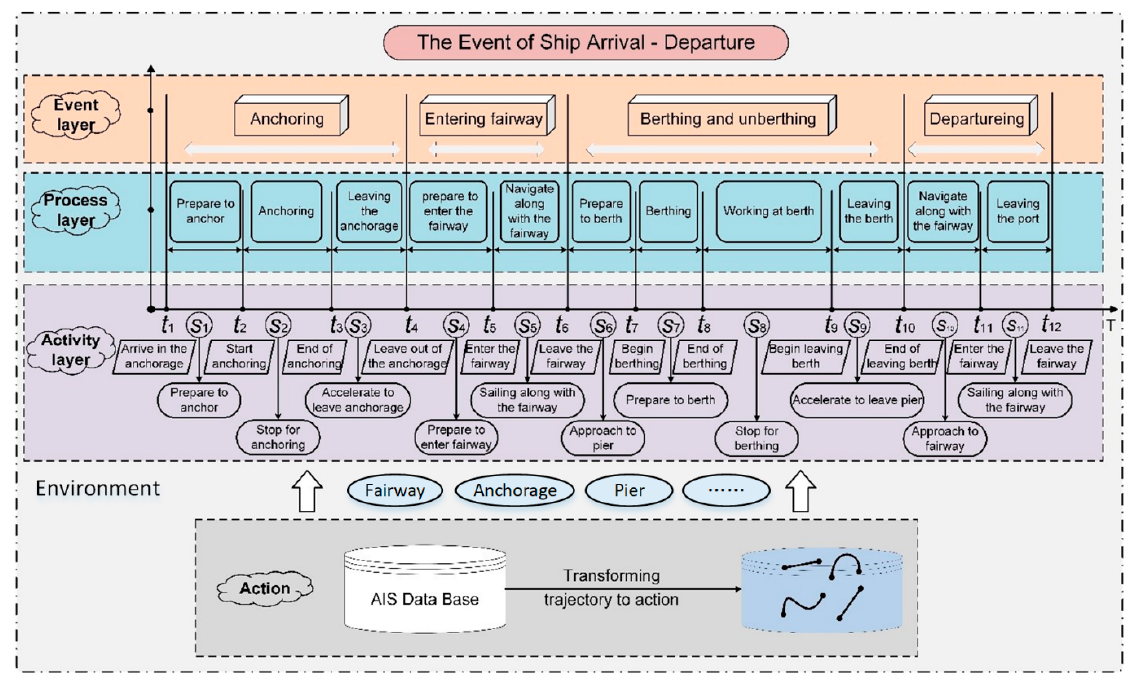
Figure 8. Cognition graph of the behavior of ship arriving and leaving the port.